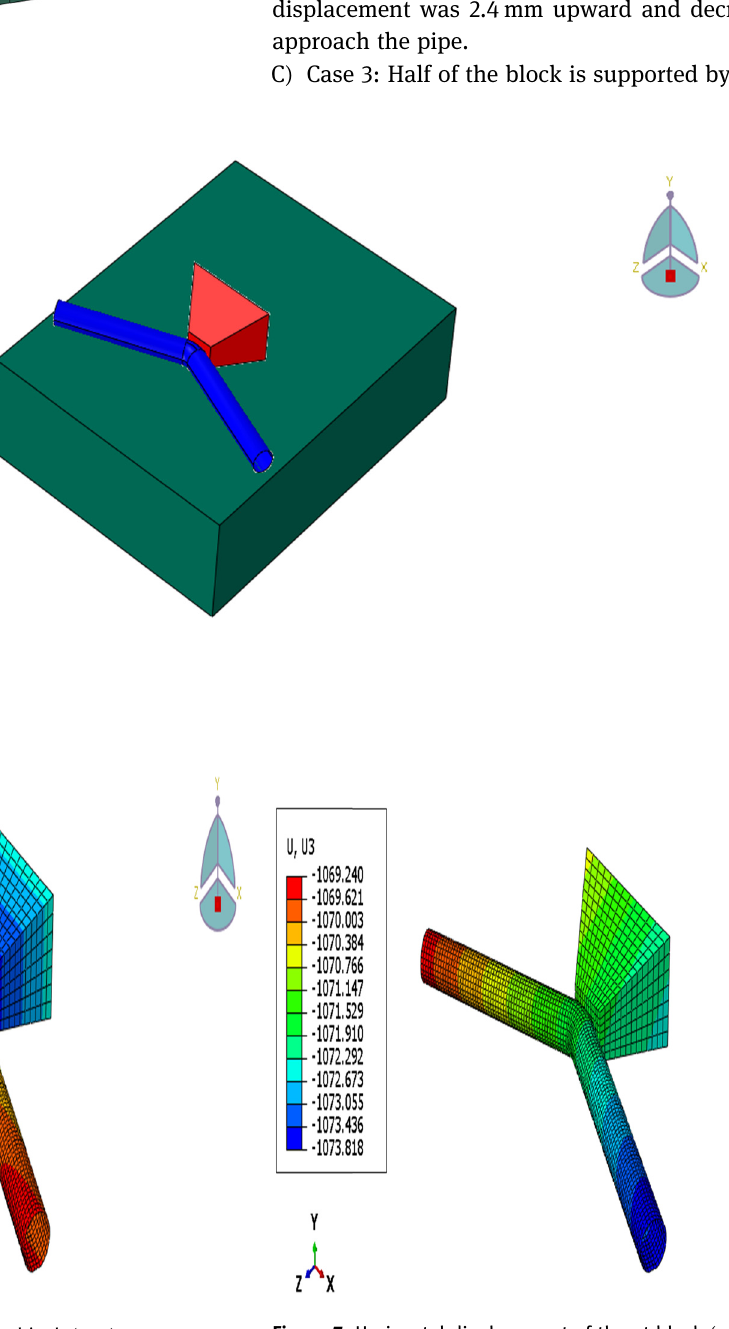
Figure 6: Vertical displacement of thrust block ( mm ) . Figure 7: Horizontal displacement of thrust block ( mm )